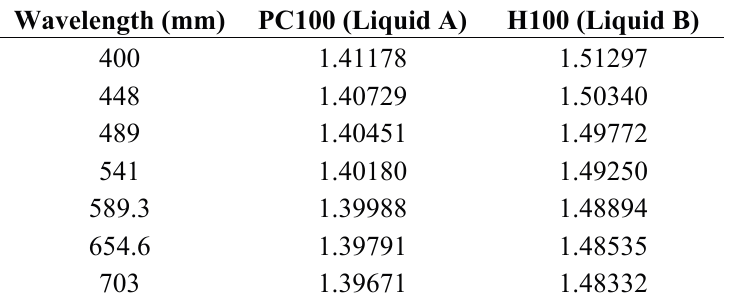
Table 5. Liquid index at 20 °C.